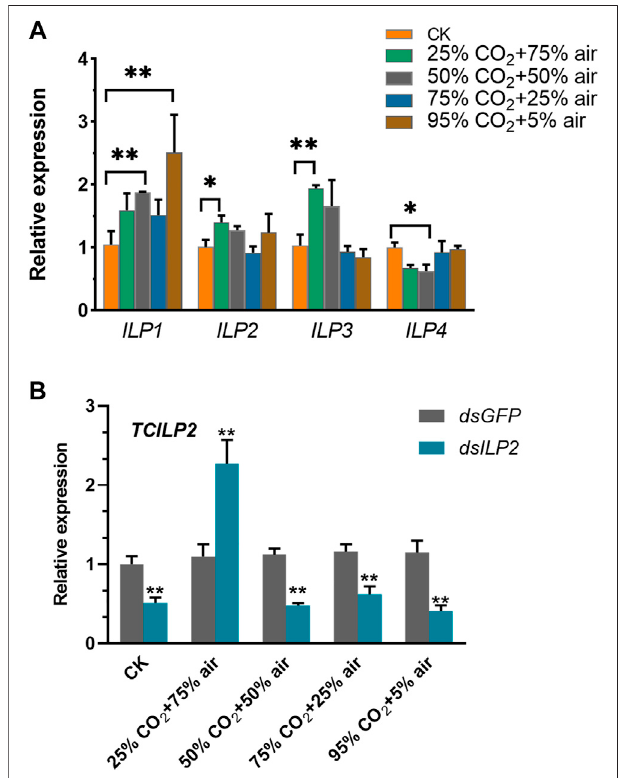
FIGURE 1 | Relative expression of TcILP in different concentration CO 2 treatment (A) and TcILP2 (B) detectionofRNAiinterferenceeffectafternormal concentration and high concentration CO 2 respectively. T. castaneum larvae were divided into three groups (each group covered 10 larvae) and used totreatwith25%CO 2 +75%air,50%CO 2 +50%air,75%CO 2 +25%airand 95% CO 2 + 5% air, respectively. Samples were collected for 48 h treatment and mRNA expression level were detected by q-PCR. The mRNA level was normalized to that of TcRPL13a mRNA. Signi fi cant differences were identi fi